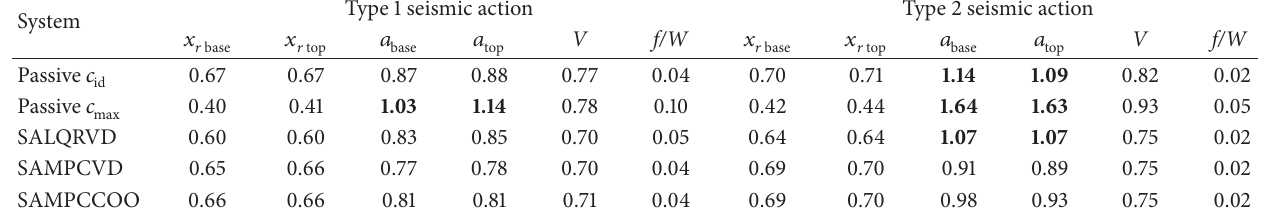
Table 1: 10-storey base isolated building results. Comparison in terms of mean response peak values ratios: relative displacements, accel- erations (at base and top) and base shear force V , in relation to the original structure; and peak device’s force ratio f/W in relation to the structure’s weight W .